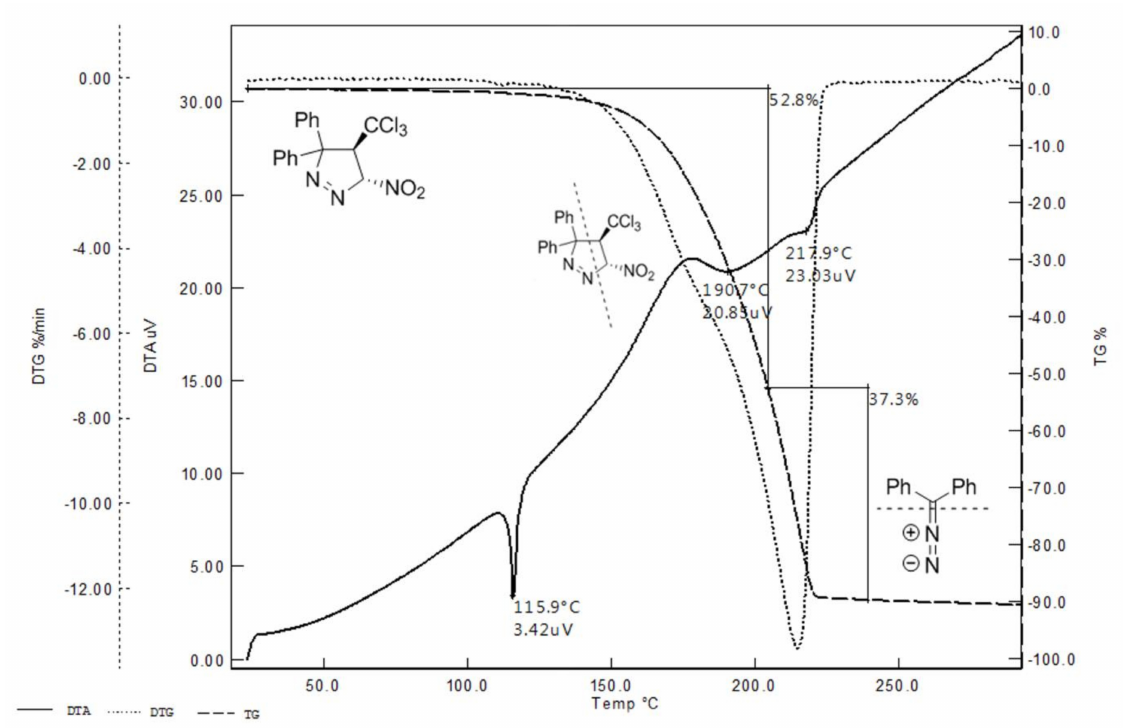
Figure 3. The course of decomposition of 3,3-diphenyl-4-(trichloromethyl)-5-nitropyrazoline 3 during heating in the range of 20–300 ◦